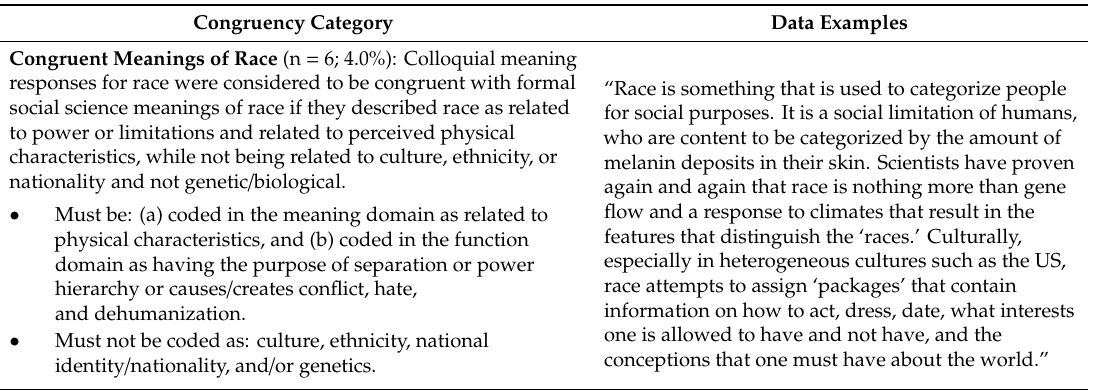
Table 7. Examination of congruence between colloquial meanings and social science definitions of race. Congruency Category Data